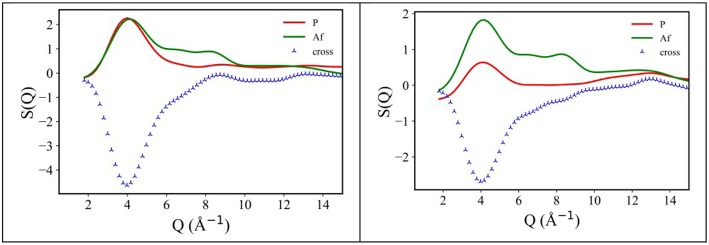
X-ray (Left) and neutron (Right) MD-computed diffraction patterns decomposition into polar-polar (P), fluorous-fluorous (Af), and polar-fluorous (cross) terms, for [C4mim][IM14] at ambient conditions.